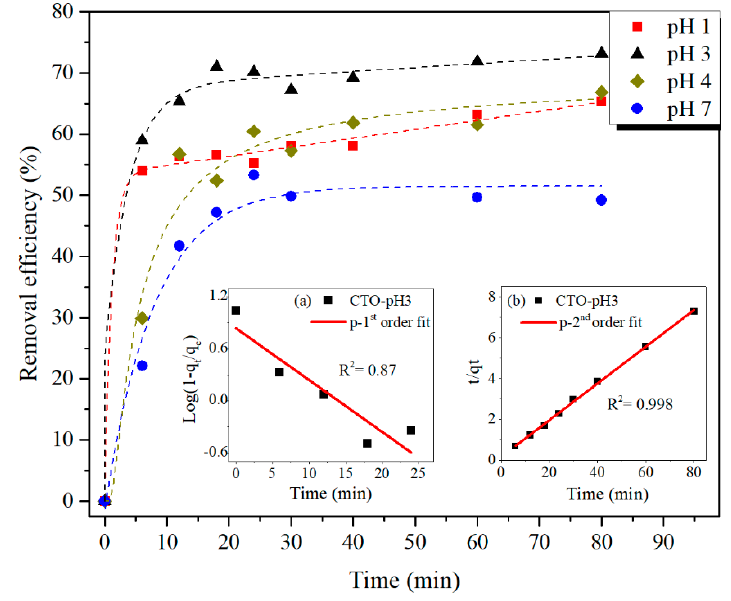
Figure 9. Time dependent adsorption behavior of As(III) by CTO nanoparticles at different pHs. For the sake of clarity, the curves of pH 2 and 5 are not included. Inset: Linear fit of the kinetic adsorption at pH 3 by a ) pseudo-first and b ) pseudo-second order models.